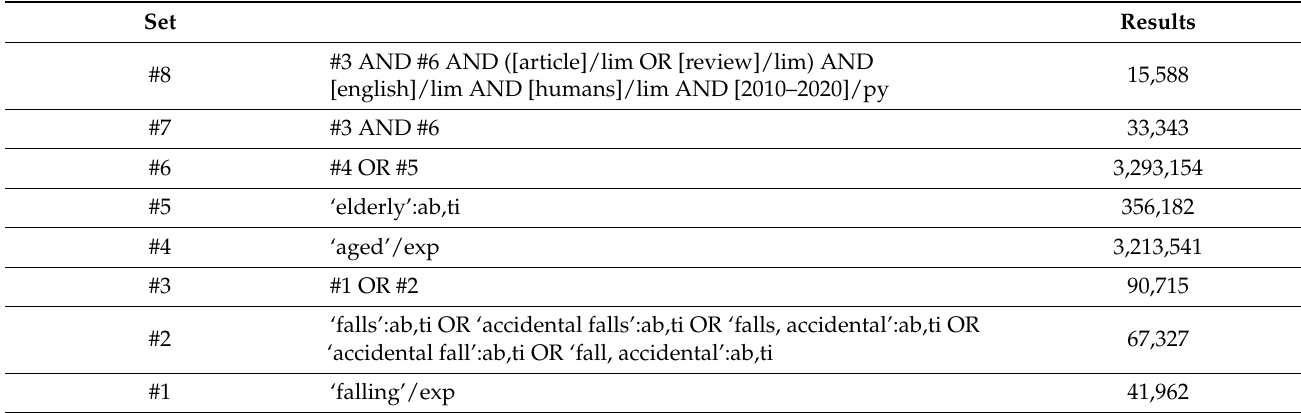
Table A2. Search history from